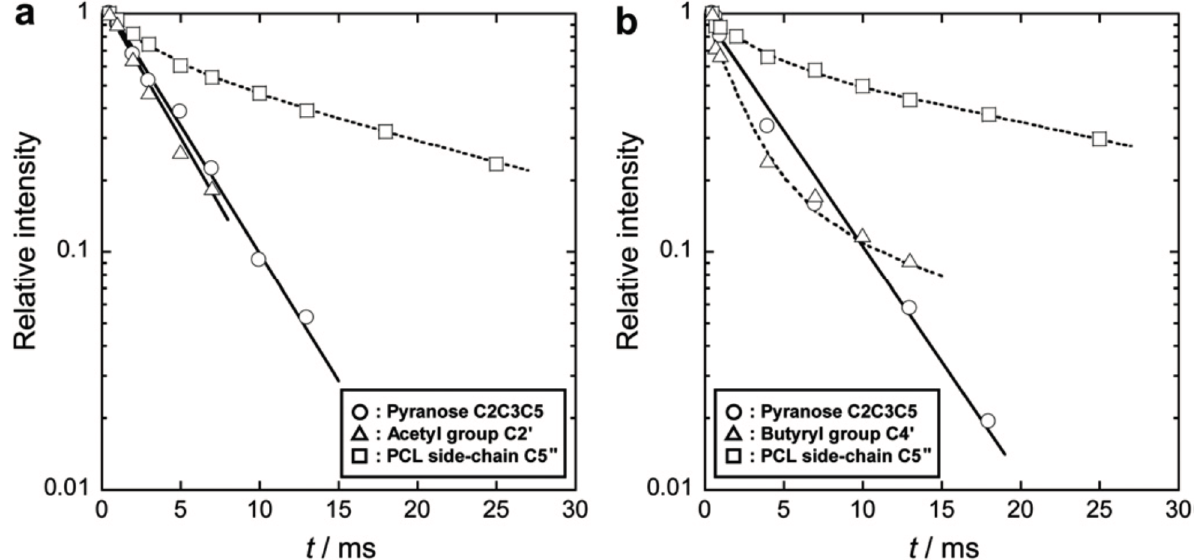
Figure 25. Semilogarithmic plots of 13 C resonance intensity decay as a function of spin-locking time t for ( a ) CA 2.15 - g -PCL 9.70 and ( b ) CB 2.10 - g -PCL 9.03 films. Straight lines represent fits to a single-exponential function (see Equation (3)) for the acetyl C2' in CA 2.15 - g -PCL 9.70 and for the pyranose C2/C3/C5 in CA 2.15 - g -PCL 9.70 and CB 2.10 - g -PCL 9.03 . Dashed-line curves correspond to fits to a double exponential function (see Equation (4)), where x f = 0.34 and x s = 0.66 for the PCL side-chain C5" in CA 2.15 - g -PCL 9.70 , x f = 0.82 and x s = 0.18 for the butyryl C4' in CB 2.10 - g -PCL 9.03 , and x f = 0.32 and x s = 0.68 for the PCL side-chain C5" in CB 2.10 - g -PCL 9.03 . Reproduced with permission from ref. [60]. Copyright 2011 Elsevier